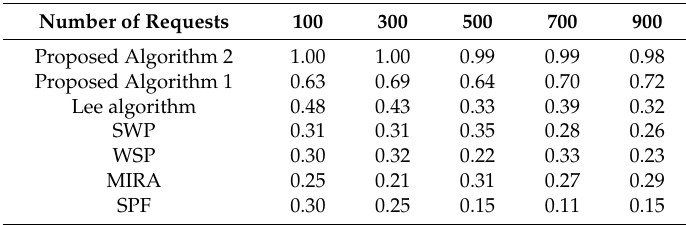
Table 3. The average value of the comprehensive evaluation path when the scheme weight have the same importance.